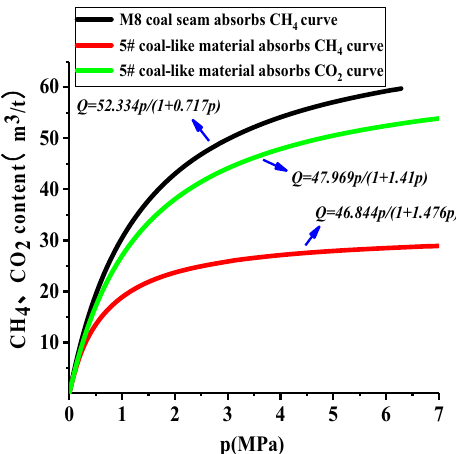
Fig. 12 The adsorption curves of M8 and No. 5